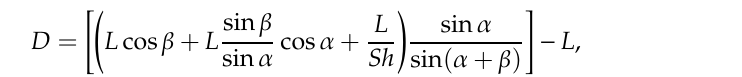
Figure 10. ( a ) Comparison of the percentage of shading available in the greenhouse with the fixed horizontal PV panels and the percentage of shading necessary to guarantee the minimum threshold; ( b ) comparison of the percentage of shading available in the greenhouse with the fixed horizontal PV panels and the percentage of shading necessary to guarantee the maximum threshold.